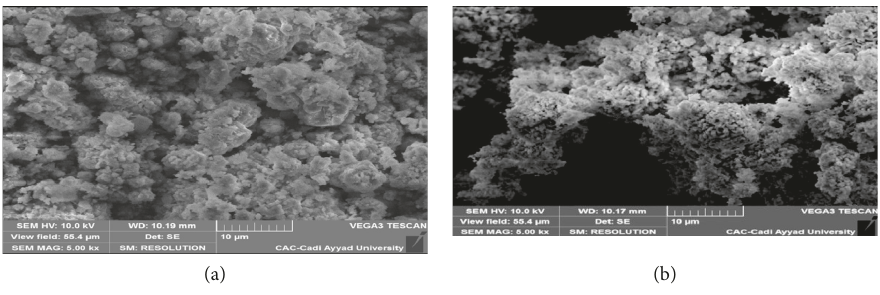
Figure 9: SEM of (a) sugar scum powder and (b) optimal adsorbent. Table 6: EDX of sugar scum powder and optimal adsorbent. Element Sugar scum powder Optimal